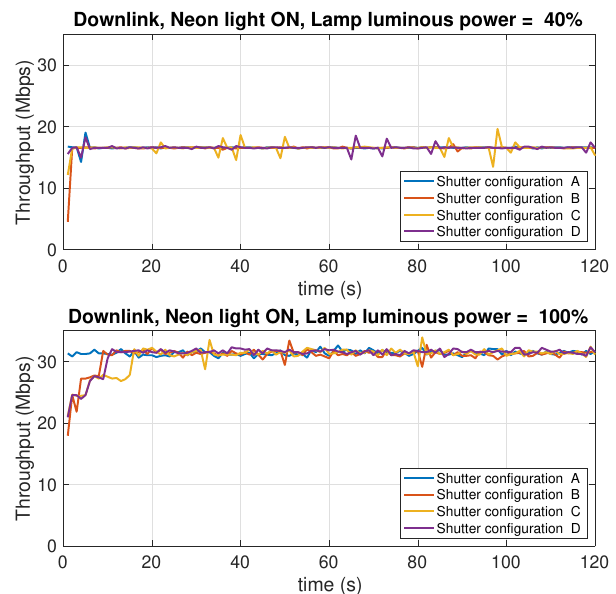
Figure 21. Downlink throughput with different shutter configurations (see Table 1). Neon lights ON. LED lamp luminous power: 40% (top charts) and 100% (bottom charts) of the maximum luminous power of 1930lm.